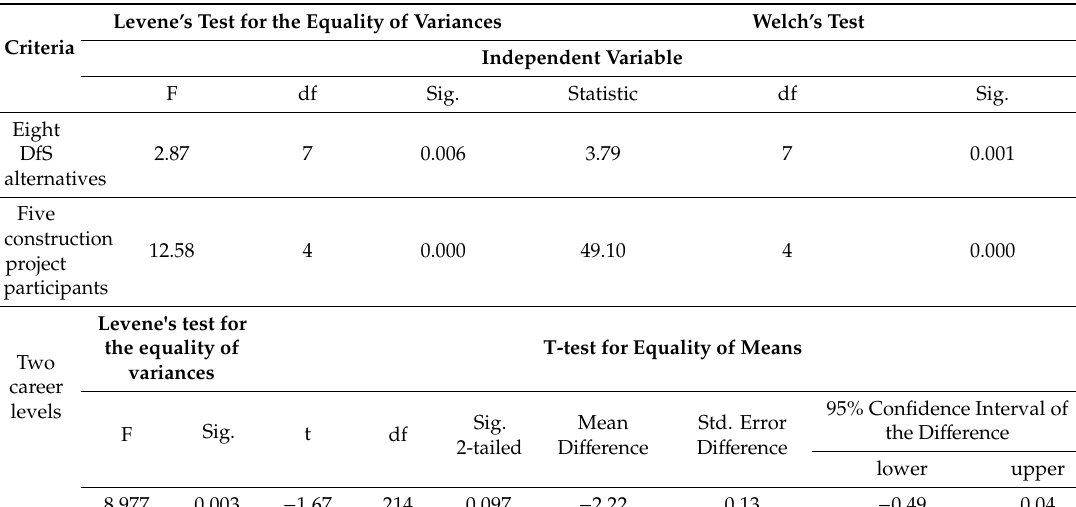
Table 4. Result of the independent